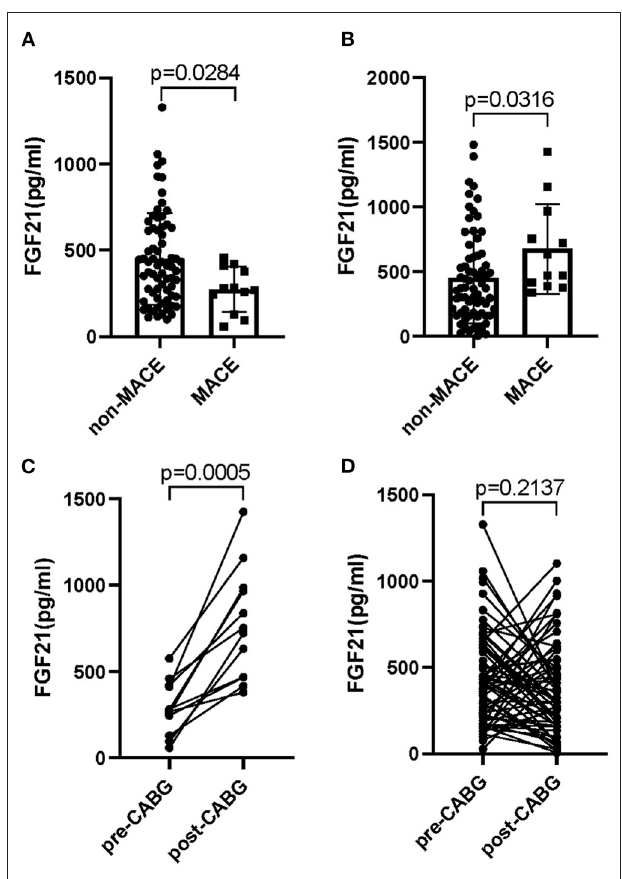
FIGURE 1 | Circulating levels of FGF21 in patients with MI who had undergone CABG. Serum FGF21 levels in pre-CABG (A) or post-CABG (B) in MI patients with or without MACE; Serum FGF21 levels between pre- and post-CABG in MI patients with MACE (C) and without MACE (D)